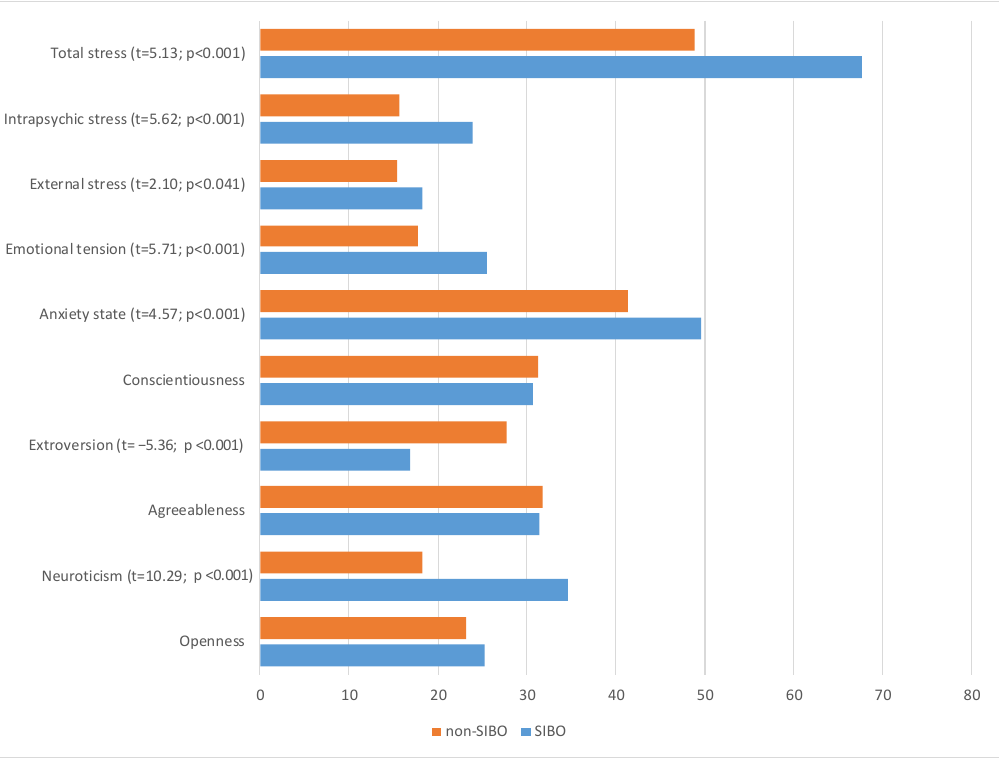
Figure 1. Subgroup differences in personality, anxiety, and stress expressed in means indicators.